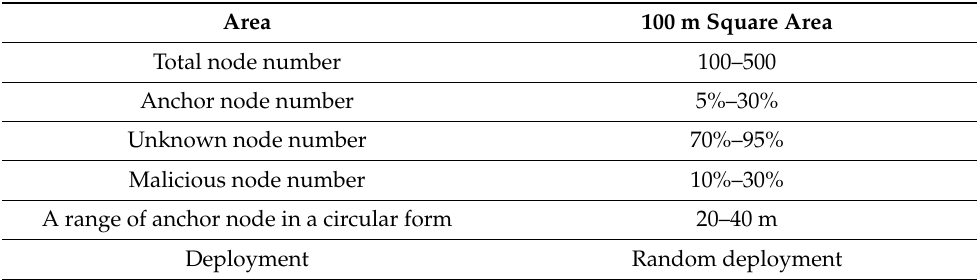
Table 3. Simulation